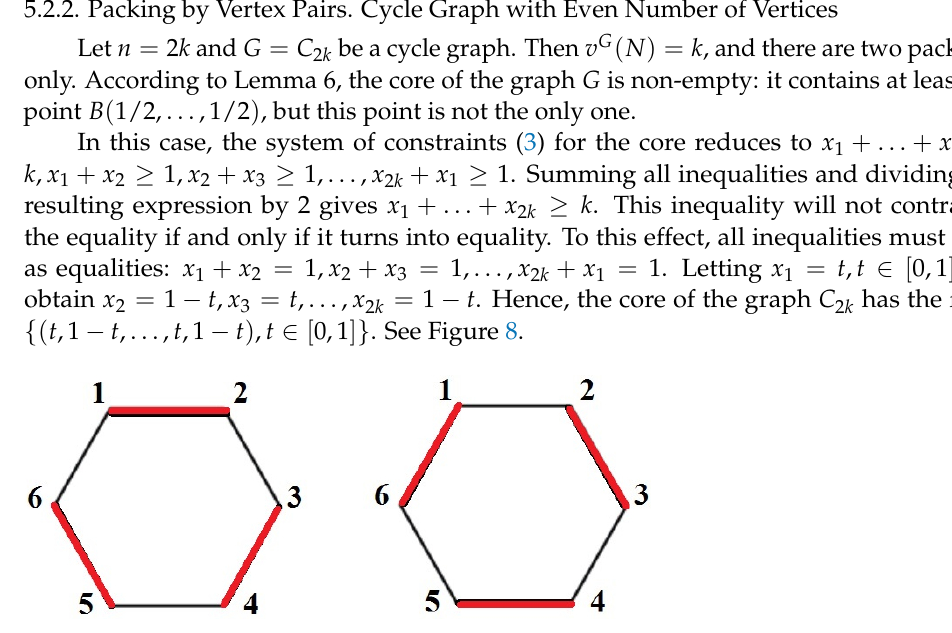
Figure 8. Two packings of C 6 . All vertices are in the